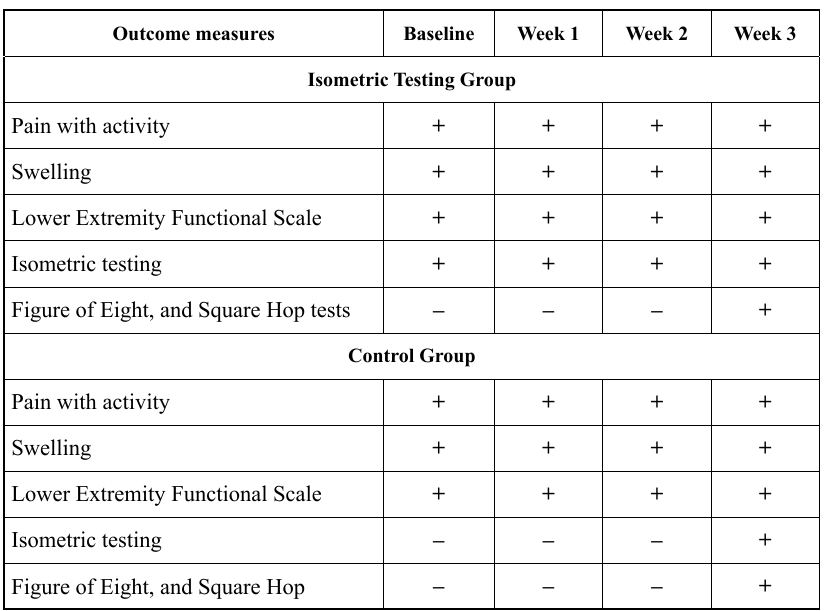
Table 1. Visit schedule and outcome measures taken on each